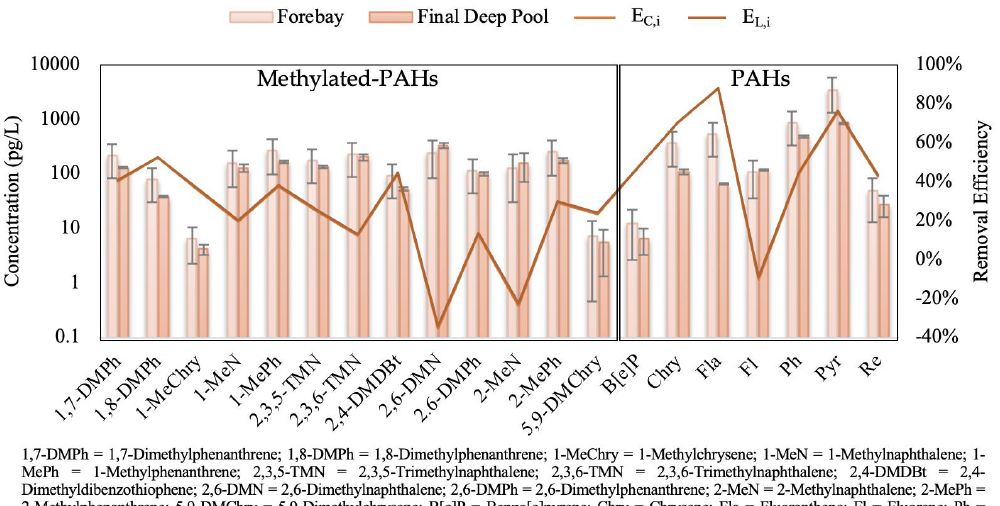
Figure 3. Dissolved aqueous concentrations and removal efficiencies of PAHs in the Kearl Treatment Wetland during deployment two (2017B). Error bars represents standard errors of the mean.